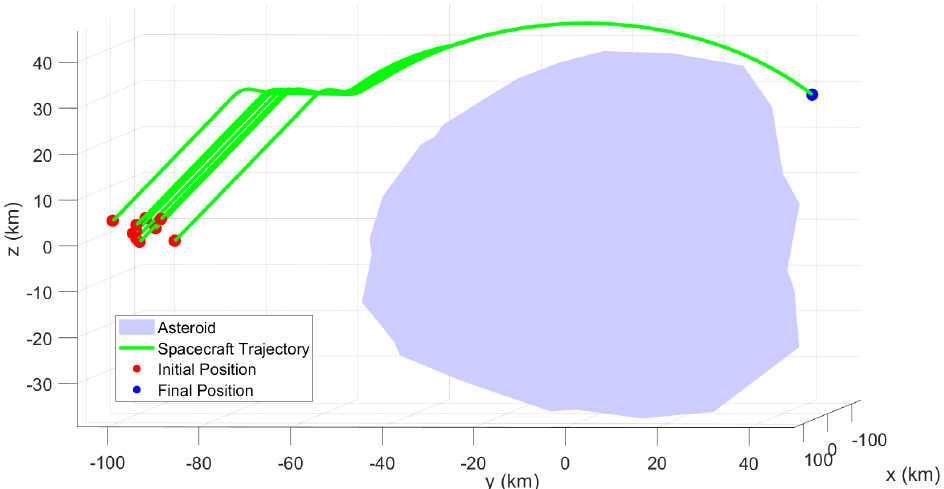
Figure 16. Spacecraft trajectories with varying initial